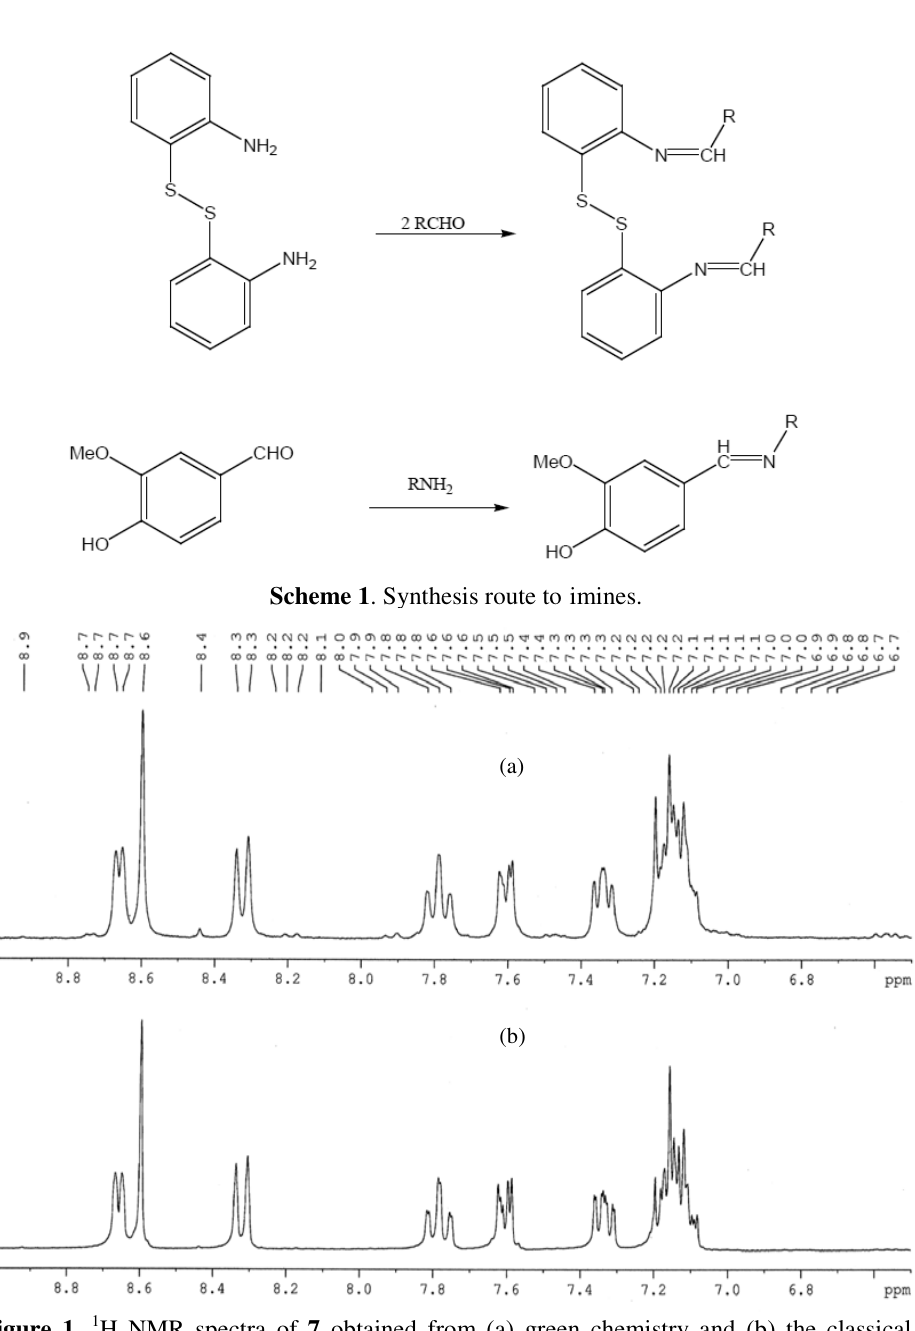
Figure 1 . 1 H NMR spectra of 7 obtained from (a) green chemistry and (b) the classical